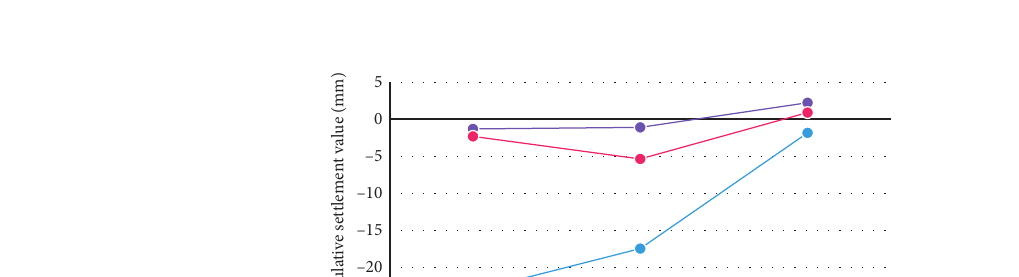
Table 8: Change of lateral displacement of a monitoring section in Wannianquan Road Station. Test group A B C Accumulated settlement value after excavation (mm)